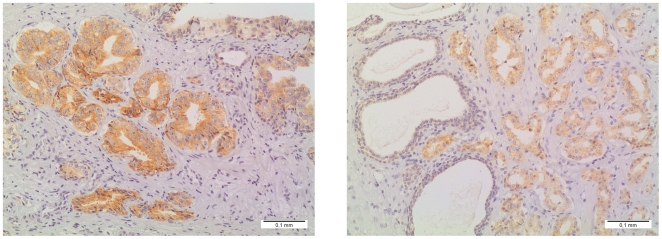
Immunoexpression of CRISP3 in prostate adenocarcinoma.The neoplastic glands demonstrate intense (left) to moderate (right) cytoplasmic staining comparatively to normal prostatic epithelium (shown in the right picture).